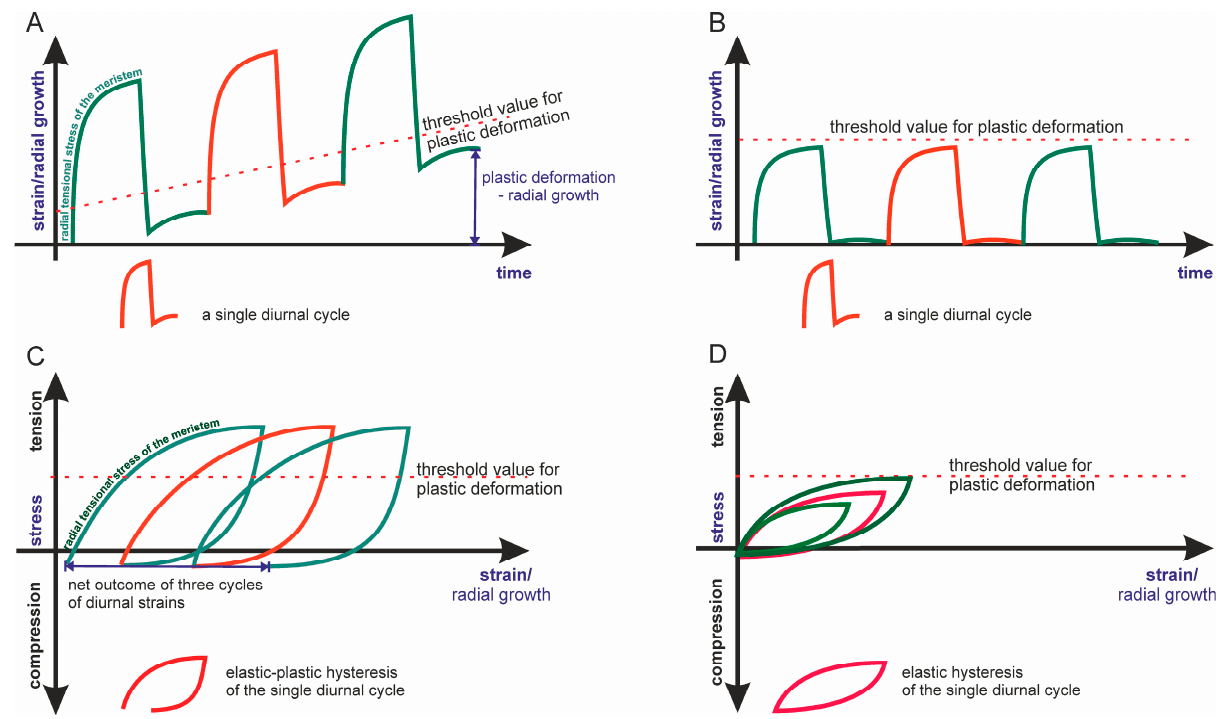
Figure 8. Proposed scheme of diurnal strains of the vascular cambium: elastic–plastic ( A , C ) and elastic ( B , D ). Deformation of the cambium due to a force exceeding threshold value is partially irreversible ( A ), while below threshold value it is fully reversible ( B ). Elastic–plastic deformation can be visualised using a hysteresis loop, which illustrates how the tissue deforms under tensile stress during successive loading cycles ( C ). In contrast, for deformations below threshold value, a deformation will be purely elastic ( B ) and can be visualised using multiple elastic hysteresis loops, which have no plastic component ( D ). In this case, we will not observe radial growth of the tree. The scheme is made on the basis of general information concerning deformation of elastic-plastic materials, such as the cell wall. Such materials under loading and relaxation cycles undergoes deformation, which has a hysteresis form on the graph (see: Burgert 2006 [195]). Its analysis indicates the potential for such a deformation of the meristematic (elastoplastic) tissue under the influence of the diurnal cycle (compare: Song and Muliana 2019 [194]). The scheme is an original development of the idea of elastoplastic deformation of the vascular cambium under cyclic radial strains and their relaxation by the phloem in a diurnal cycle presented in Figures 6 and